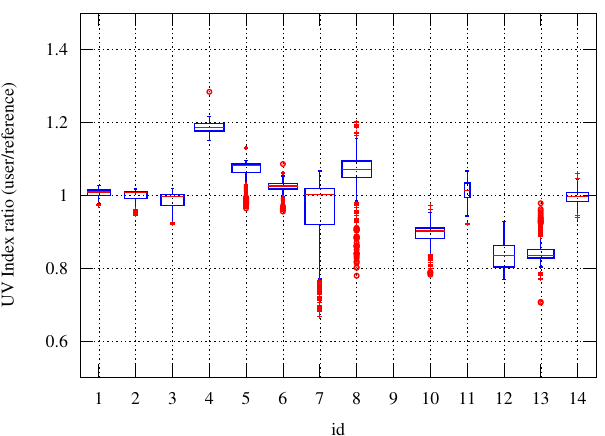
Fig. 4. Comparison of several methods to downscale the broad- band data. The graph shows the ratio of the broadband irradi- ance measured with instrument 01 and the reference during three cloudy days. Cubic spline interpolation is represented with green diamonds, simple linear interpolation with pink crosses, the COST Action 726 algorithm with red asterisks and the algorithm used in this study with blue circles.